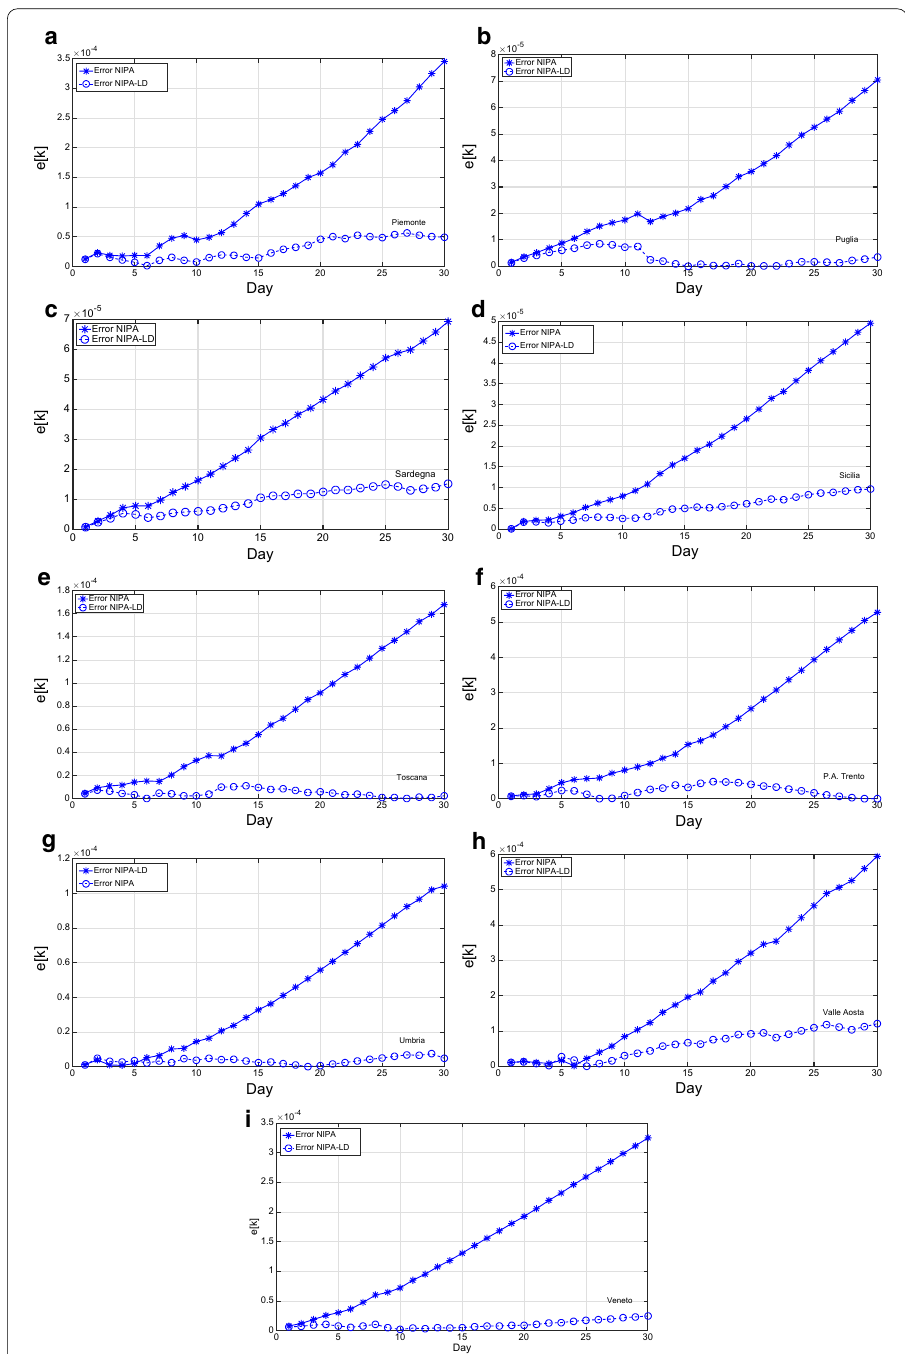
Fig. 10 Mean relative prediction error for the period from May 10th to June 9th: 9